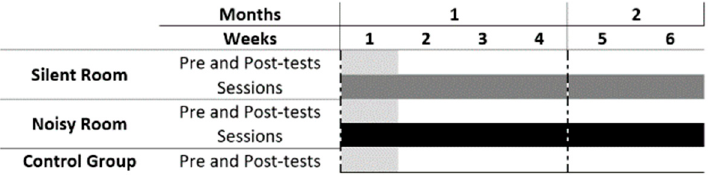
Figure 1. Timeline of the NFT training sessions and respective performance tests (pre and post tests).